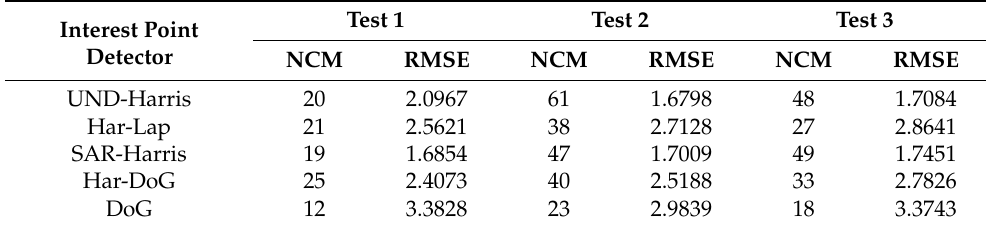
Table 6. Registration accuracy of five